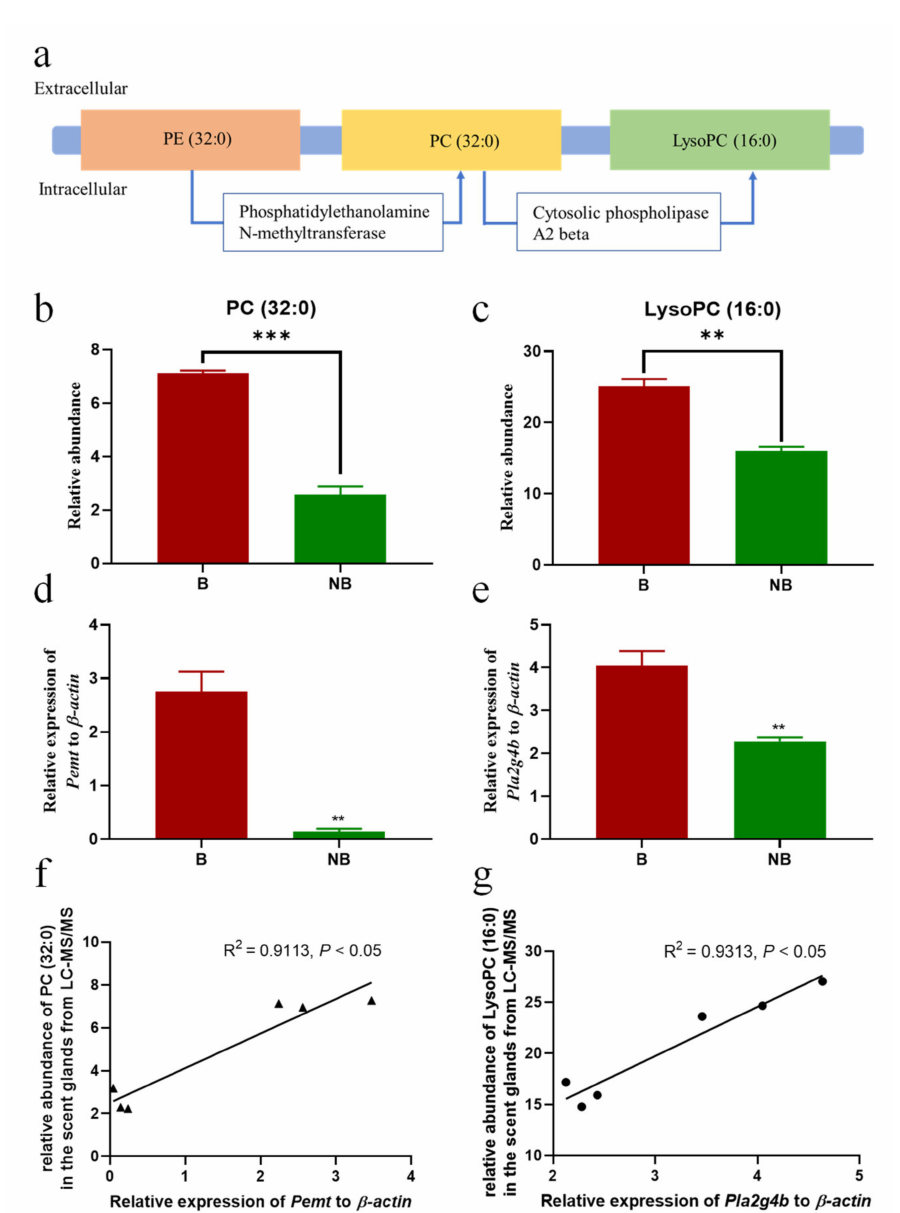
Figure 5. Schematic diagram of metabolic pathway and expression histogram of metabolite synthase. ( a ) A schematic diagram showing membrane-localized PC (32:0) and LysoPC (16:0) and the enzyme mediating the conversion of compounds in the scent glands of muskrats. ( b , c ) Relative quantification results for PC (32:0) and LysoPC (16:0) in the scent glands detected by LC-MS/MS during the breeding and non-breeding seasons. ( d , e ) Relative expression of Pemt and Pla2g4b in the scent glands of muskrats during the breeding and non-breeding seasons. ( f , g ) The linear correlation and scatter diagrams of relative expression of Pemt and Pla2g4b and relative abundance of PC (32:0) and LysoPC (16:0) of the scent glands, respectively. Each dot means the relative mRNA levels and relative abundance of PC (32:0) and LysoPC (16:0) during the breeding season (n = 3) and the non-breeding season (n = 3). B, the breeding season; NB, the non-breeding season; Data represent the mean ± SEM.; * statistically significant values (** p < 0.01; *** p <